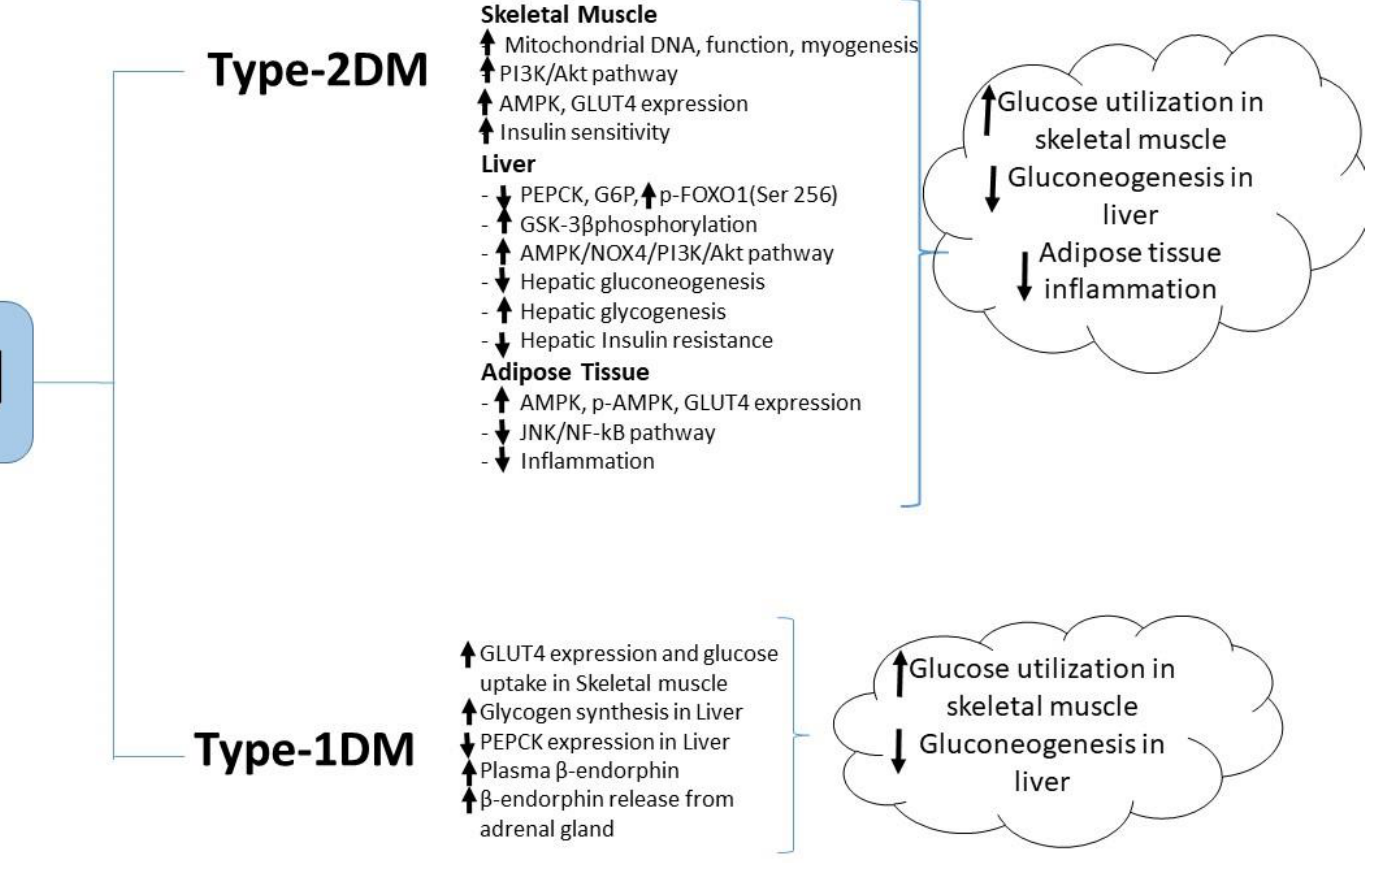
Figure 3. Molecular changes by catalpol for antidiabetic activity.